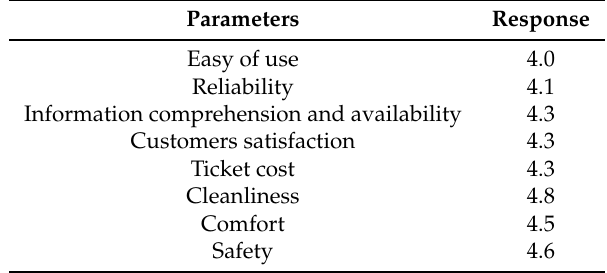
Table 2. Responses for service quality on a scale from 1–5 (where 1 means poor and 5 means excellent).